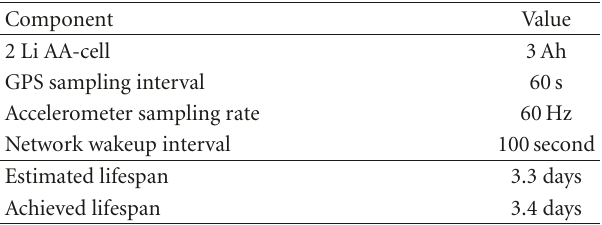
Table 4: Accelerated power test firmware settings and battery.